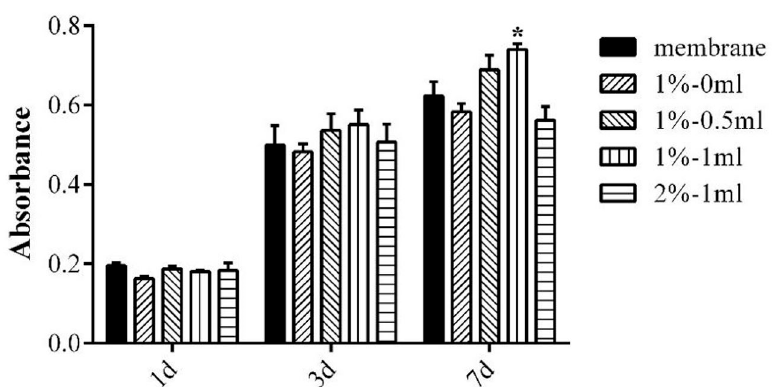
Figure 5. NIH 3T3 cells proliferation tests on different 3D nanofibrous scaffolds and membrane at culturing day 1, 3 and 7 by MTT assay. * p < 0.05, compared with pure chitosan/RHC nanofibrous membrane. Bars represent mean ± SD, number of repeats n = 3.